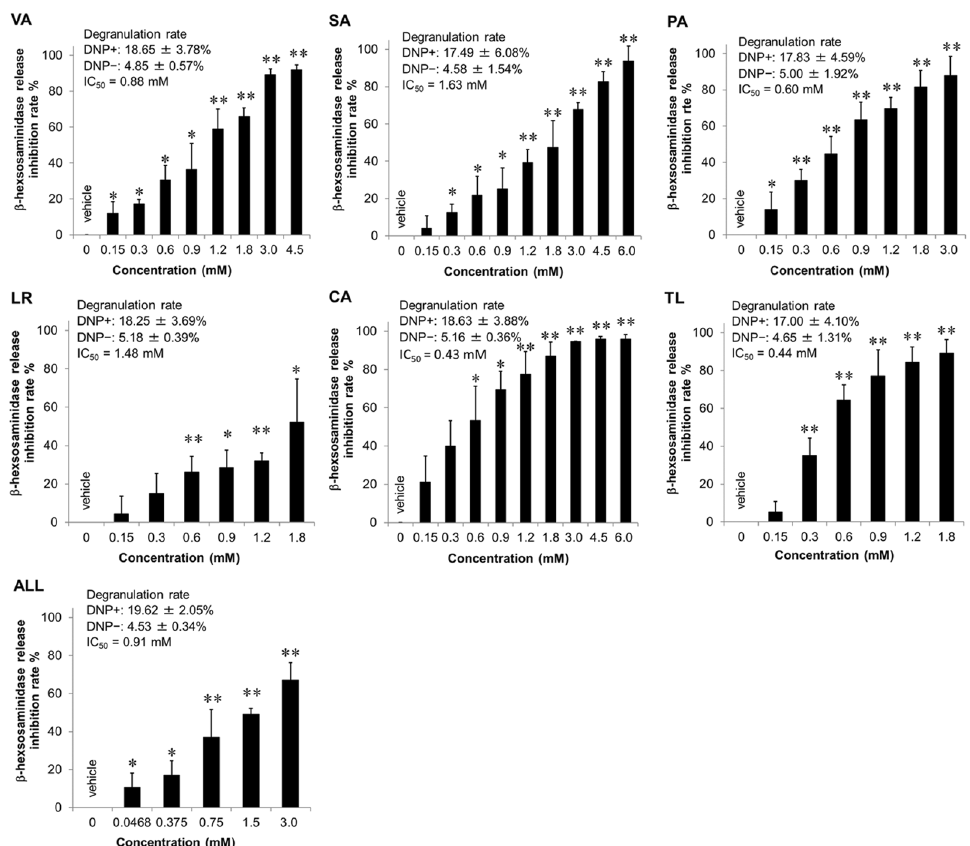
Figure 4. Inhibitory effects of active compounds derived from ume on antigen-induced degranulation of RBL-2H3 cells. IgE-sensitized RBL-2H3 cells were stimulated with DNP-BSA in the presence of ume seed extracts or vehicle (0.1% DMSO). TL was used as an anti-allergic positive control. Data represent the mean ± SD (n = 3) of β -hexosaminidase release inhibition rate of three independent experiments. ALL: equal molar concentrations of VA, SA, PA, LR and CA; ALL concentration: the total concentration of the five compounds; IC 50 : 50% inhibitory concentration on β -hexosaminidase release. Degranulation rates of maximum response when cells are treated with vehicle and DNP-BSA (DNP + ) or minimum response when cells are treated with vehicle alone (DNP-) and IC 50 are shown in the figures. * p < 0.05, ** p < 0.001, compared with